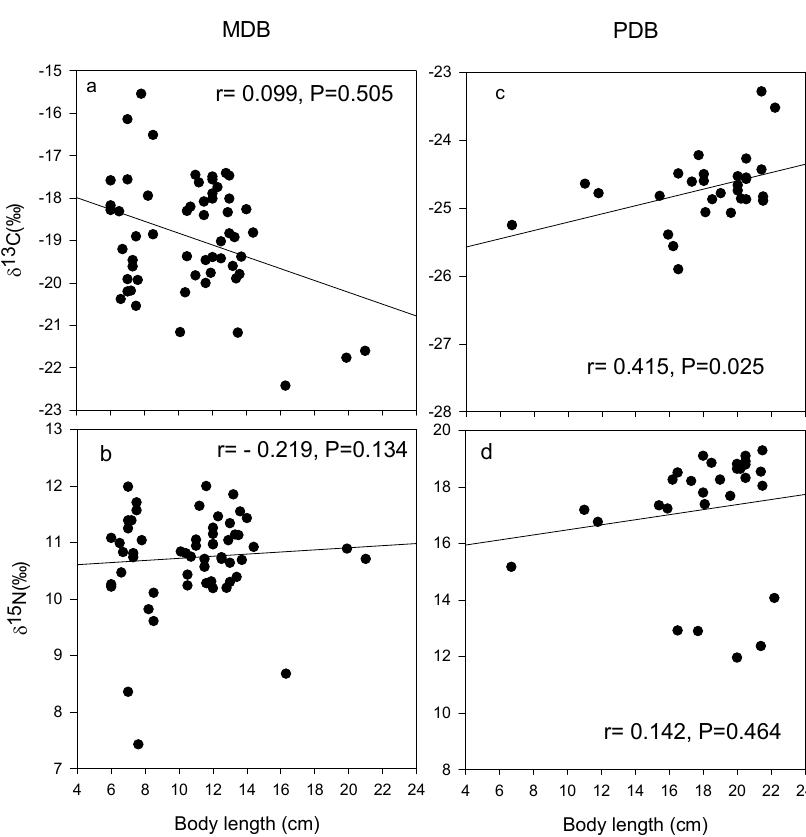
Figure A4. Relationship between crucian carp length and δ 13 C ( a , c ) and δ 15 N ( b , d ) values in MDB and PDB.